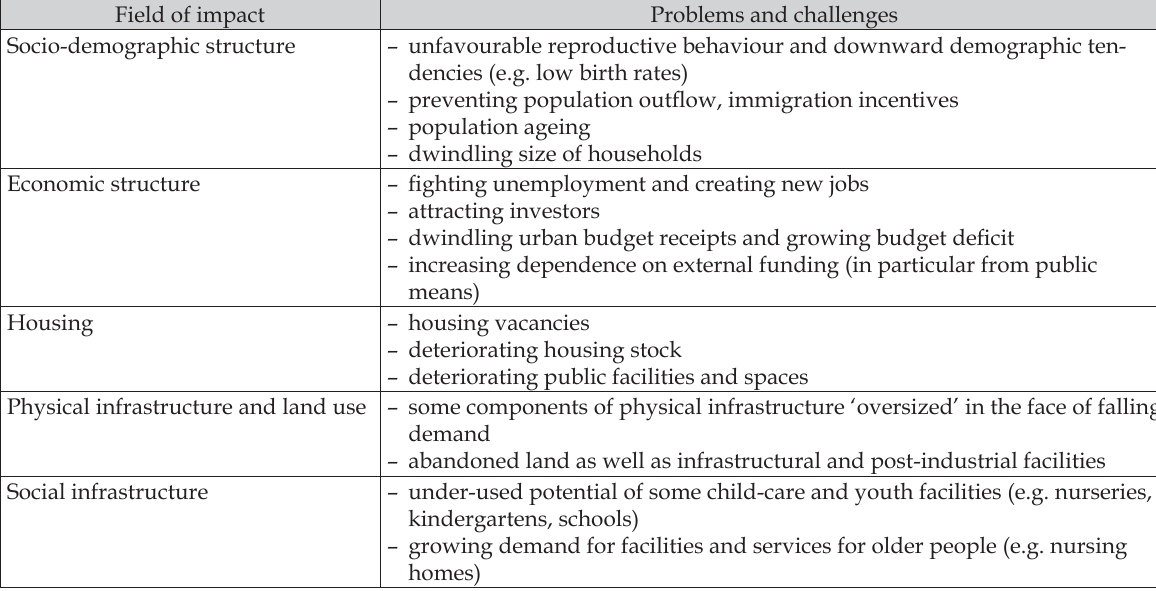
Table 1. Fields of special impact of urban policies in shrinking